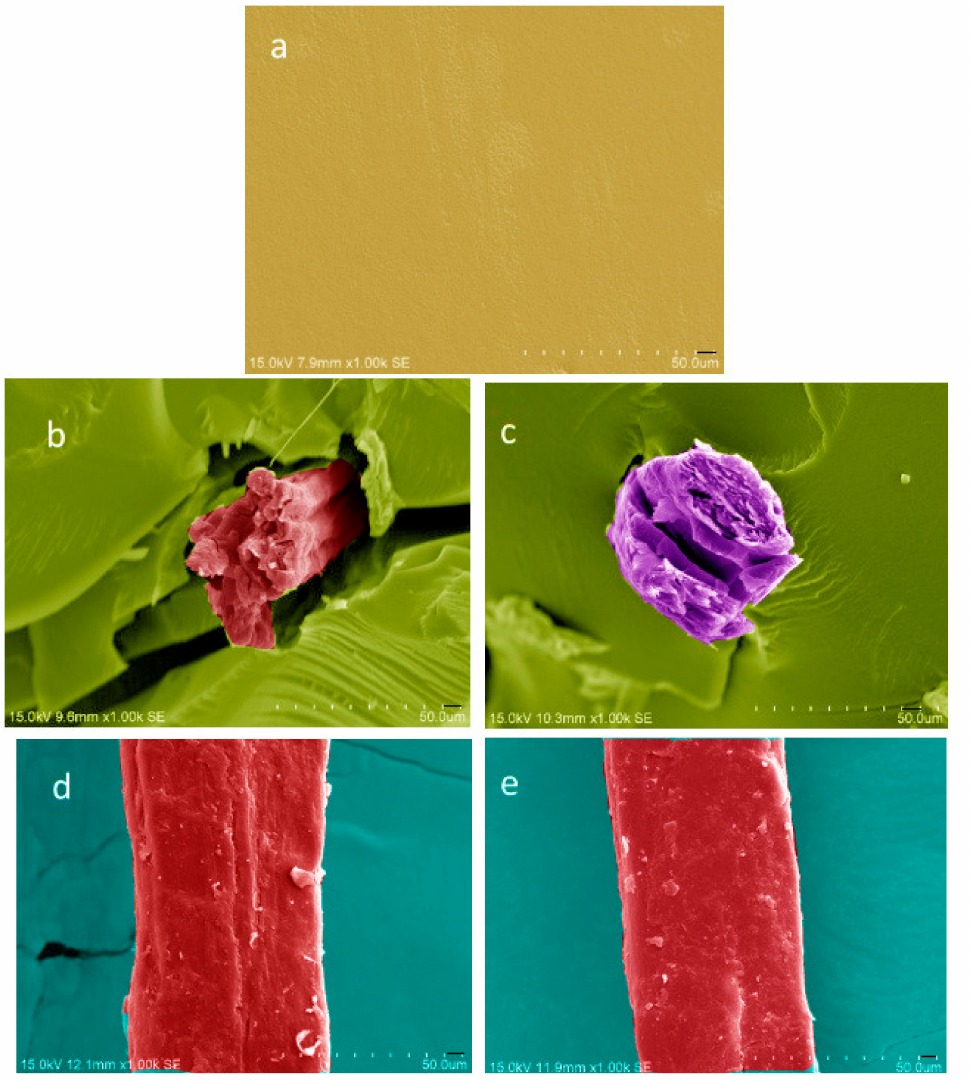
Figure 1. SEM micrographs of the PBAT composites: ( a ) neat PBAT, ( b ) PBAT/HF, ( c ) PBAT/Si-HF, ( d ) unmodified hemp fiber, ( e ) modified hemp